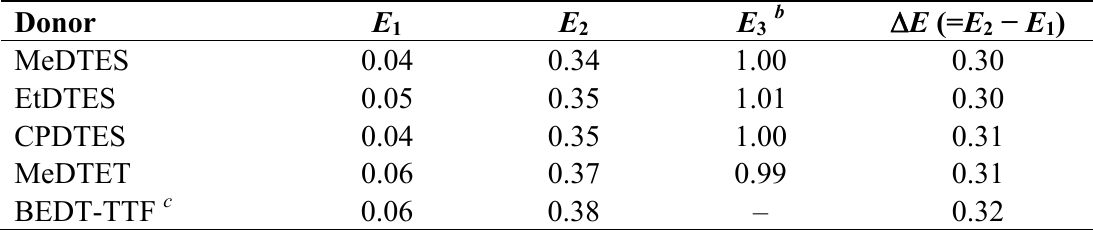
a Measured in benzonitrile containing 0.1 M n Bu